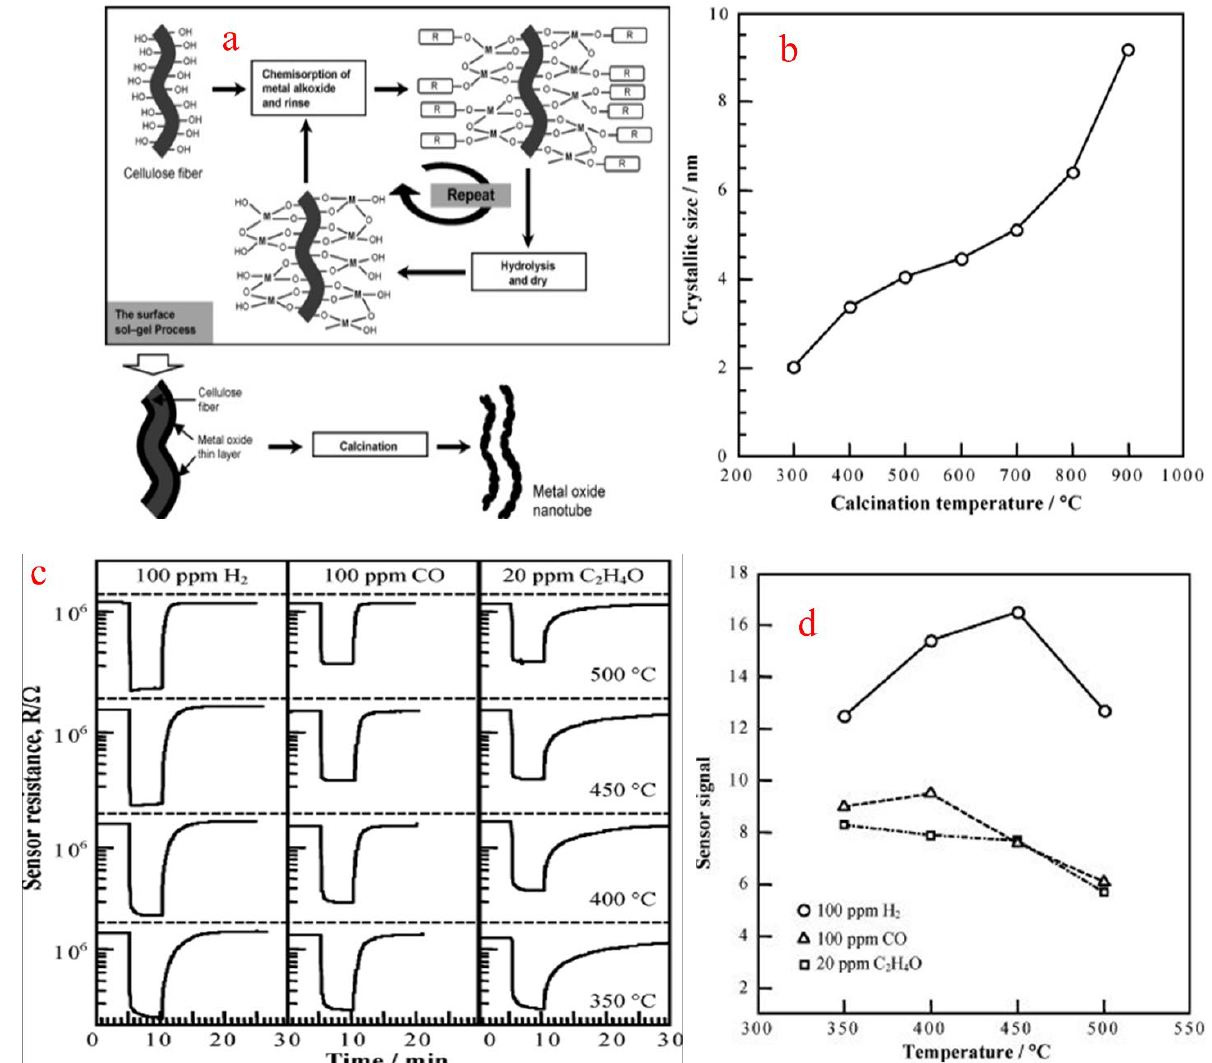
Figure 19. ( a ) Sol–gel synthesis of metal oxide nanotubes using cellulose fibers. ( b ) Dependence of SnO 2 crystallite size on calcination temperature. ( c ) Response transients of SnO 2 nanotubes for 100 ppm H 2 , 100 ppm CO and 20 ppm C 2 H 4 O at various temperatures. ( d ) Temperature dependence of SnO 2 nanotube sensor in response to 100 ppm H 2 , 100 ppm CO and 20 ppm C 2 H 4 O. (Reprinted with permission from [84]. American Chemical Society, Washington, DC, USA). Zhang et al. [85] used granulated tin to synthesize nanocrystalline SnO 2 particles by a simple sol–gel method. During the process, the granulated tin in HNO 3 solution ob- tained by dissolution is mixed with the citric acid which acts as a stabilizer and slows down the process of condensation and hydrolysis. SnO 2 nanocrystals obtained ranged from 2.8 to 5.1 nm in size and had a specific surface area ranging from 289 to 143 m 2 g −1 when different heating temperatures were employed. The obtained nanocrystallites dis- played a reduction in particle size as well as lattice expansion. Further, the precursor condenses and hydrolyzes in an uncontrolled manner in the absence of citric acid, which results in the formation of larger and broader nanocrystals with roughly spherical mor- phology. This route can be employed to synthesize tin oxide doped nanocrystallites and also serves beneficial purposes in fields such as electronics and engineering and, above all, gas sensing. Rella et al. [86] used a sol–gel technique to synthesize SnO 2 -based thin films. During the process, thin films based on Pd-doped SnO 2 and undoped SnO 2 were prepared. Sensing measurements revealed that the sensitivity of the sensor towards CO